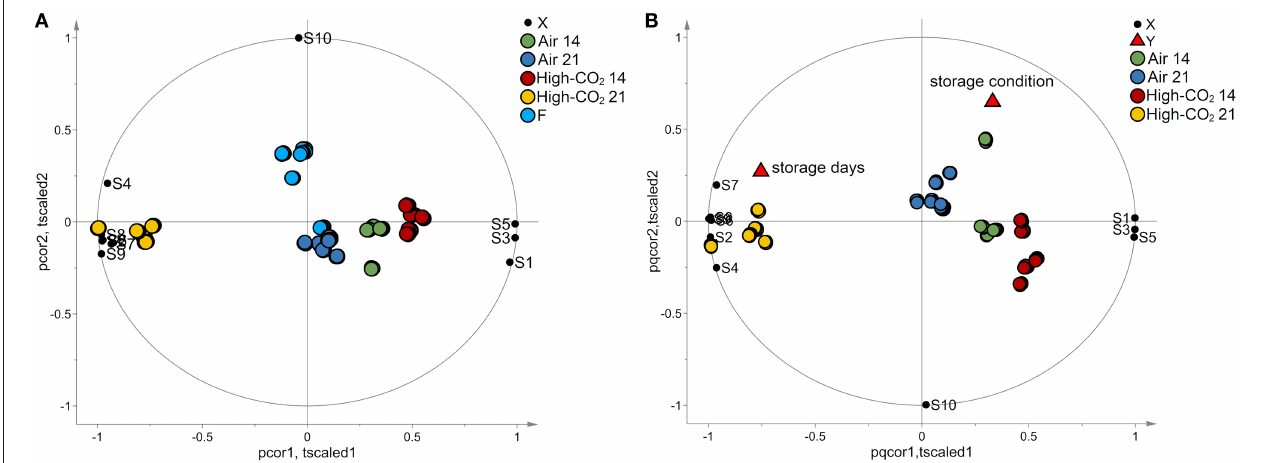
FIGURE 3 | E-nose data. In (A) , the biplot generated by PCA is reported. The points representing the E-nose sensors (black circles) are reported in the same plot of the points representing the samples of sweet cherry cv “Ferrovia” investigated in our study. Fresh samples (light blue circles) spread along the vertical axis mainly influenced by sensor S10 whereas the other samples spread along the horizontal axis. Specifically, samples with the same storage days and storage conditions are represented by points close together in the plot. In (B) , the biplot obtained by PLS analysis is reported. The points representing the E-nose sensors (black circles), the points representing the responses “storage days” and “storage condition” (red triangles), and the points representing the samples are reported in the same plot. Samples with the same storage days and storage conditions are represented by points close together in the plot. Moreover, responses and sensors positively correlated are represented by points close to each other while if they are inversely correlated, the points are centrosymmetric. The effect of storage condition is mainly explained by the behaviour of the S10 sensor whereas the data variation of the other sensors is mainly related to the effect of the storage